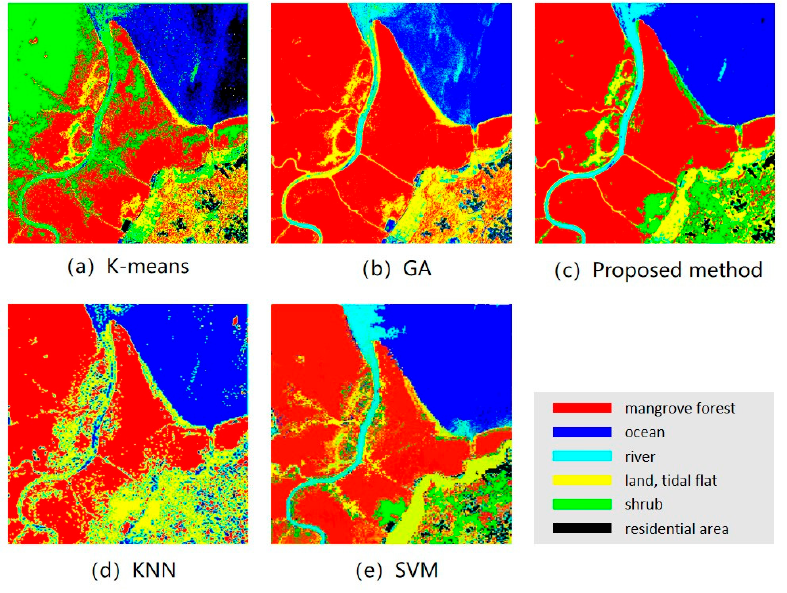
Figure 14. Output results for Data